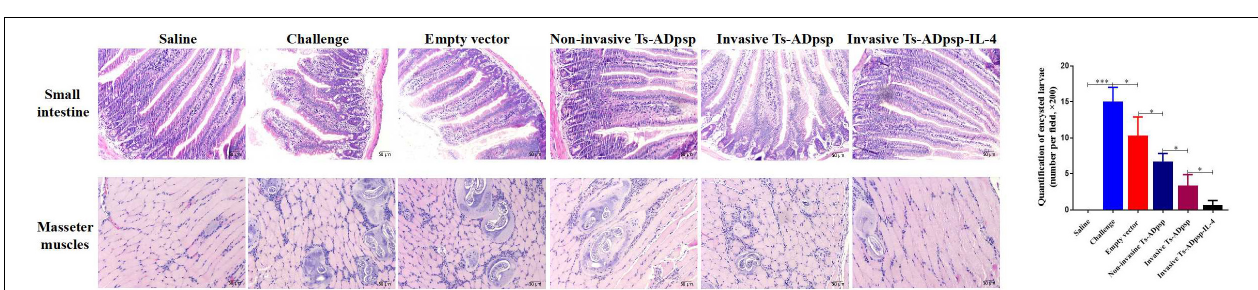
FIGURE 8 | Histopathologic analysis of small intestine and masseter muscles after T. spiralis infection. Mice were challenged with 350 T. spiralis muscle larvae, and histologic analysis was performed by hematoxylin and eosin staining (200 × magnification). Quantification of encysted larvae. * P < 0.05, ** P < 0.01, and *** P <